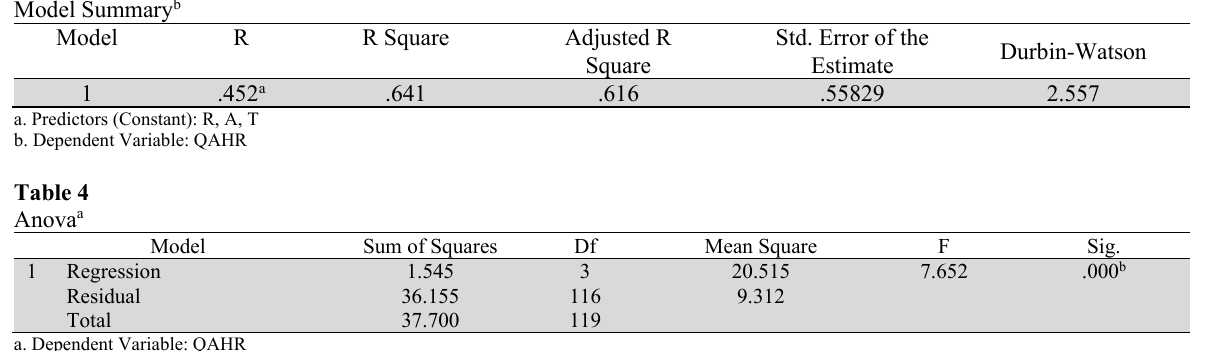
Regression Model Analysis Result